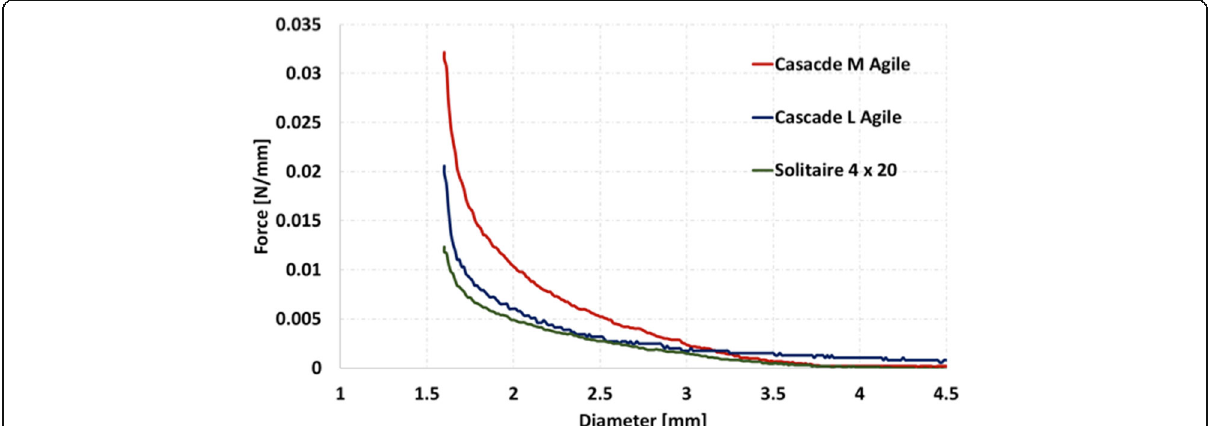
Fig. 7 The COF of the Cascade M, L Agile and Solitaire 4x20mm devices. The Cascade M Agile showed persistently higher COF compared to the other devices